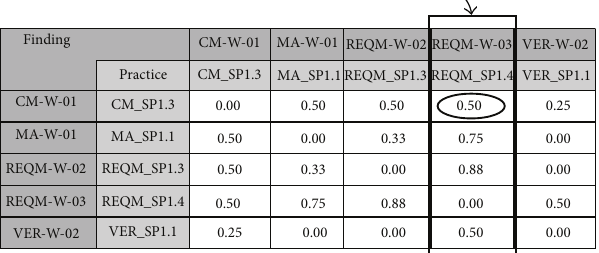
model over the number of manually identified